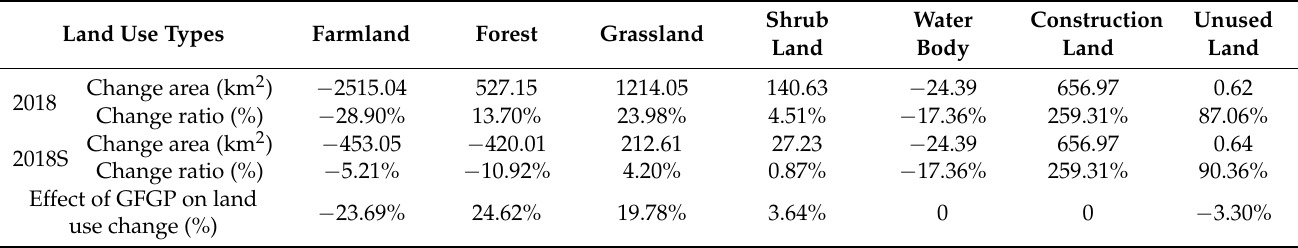
Table 3. Land use changes from 2000 to 2018 and 2018S. 2018S: the scenario if the GFGP were not implemented. Land Use